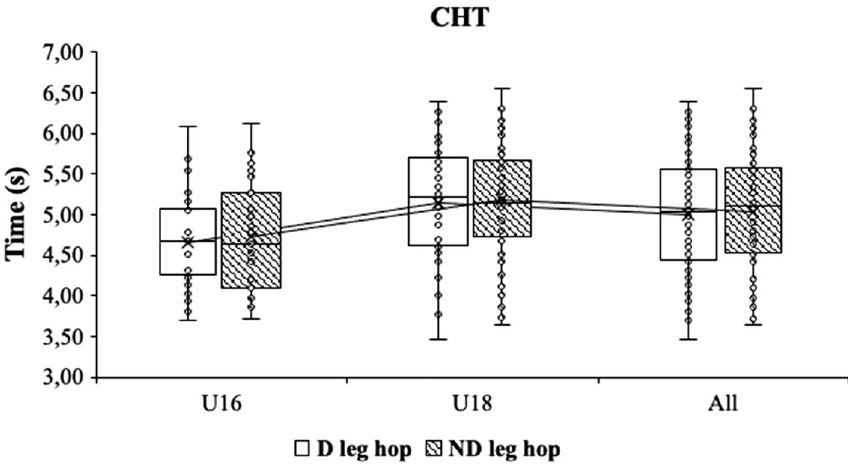
Figure 5. Intragroup comparisons of the change of direction text. CHT cross-over hop test, D dominant, ND non-dominant.